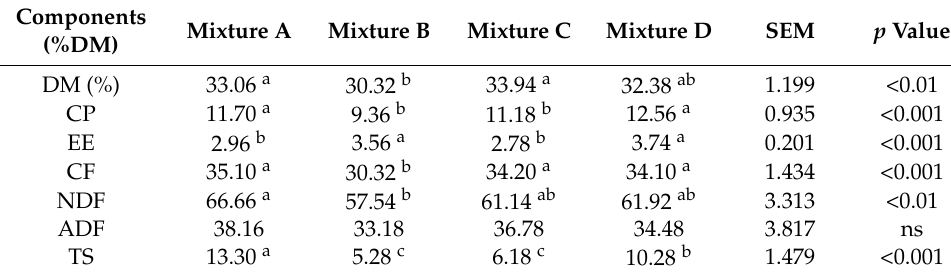
Table 2. Chemical compositions of ensiled mixtures at the end of 90 days fermentation ( n = 20).